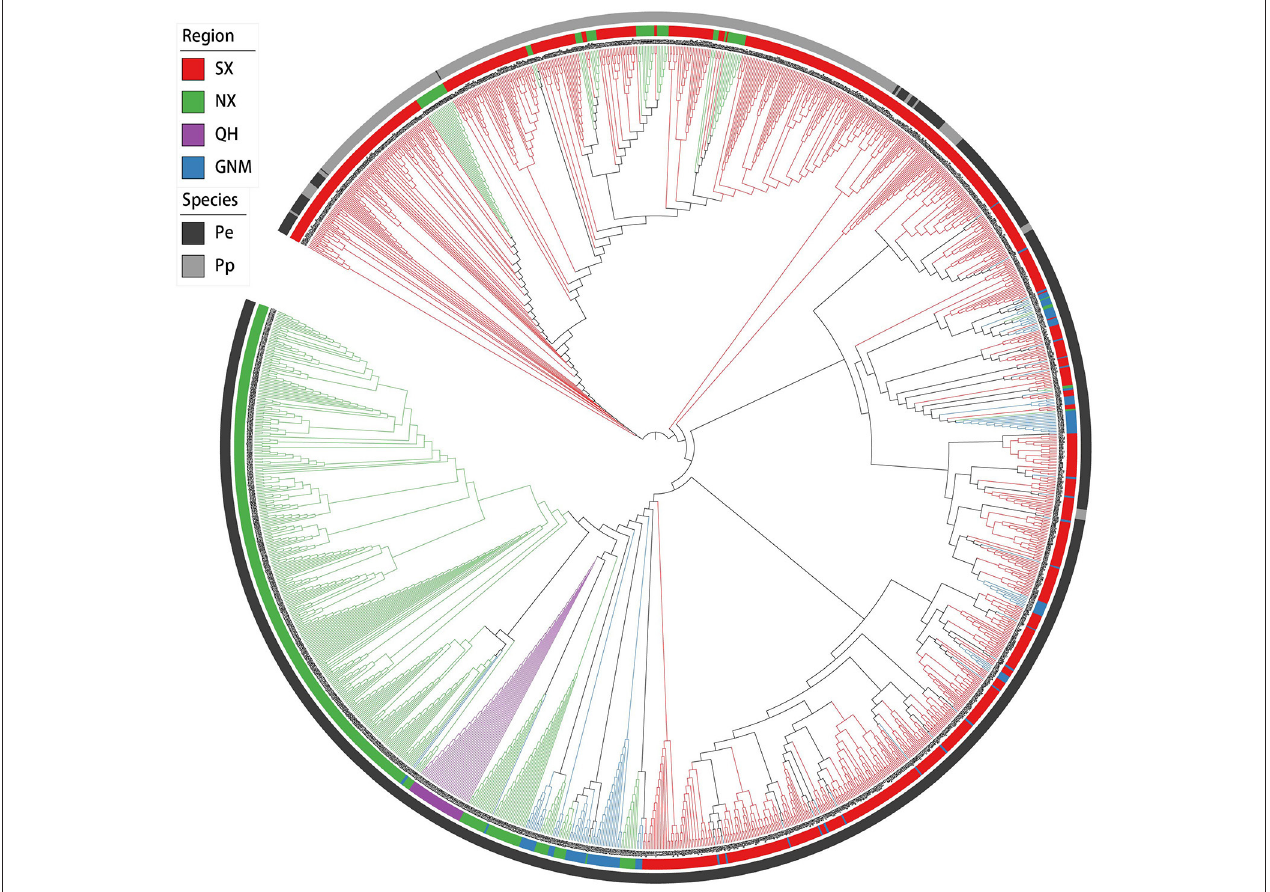
FIGURE 4 | Neighbor-joining phylogenetic tree based on a genetic distance matrix representing the grouping of 1,183 P. euphratica and 437 P. pruinosa individuals.